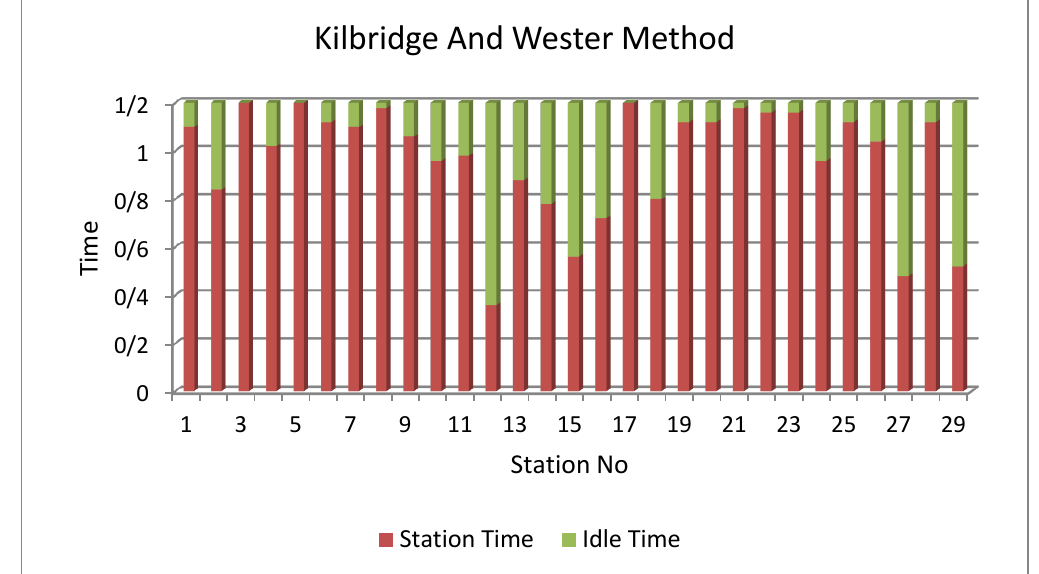
Figure 8. Service time and idle time of Kilbridge and Wester's Method (KWM).